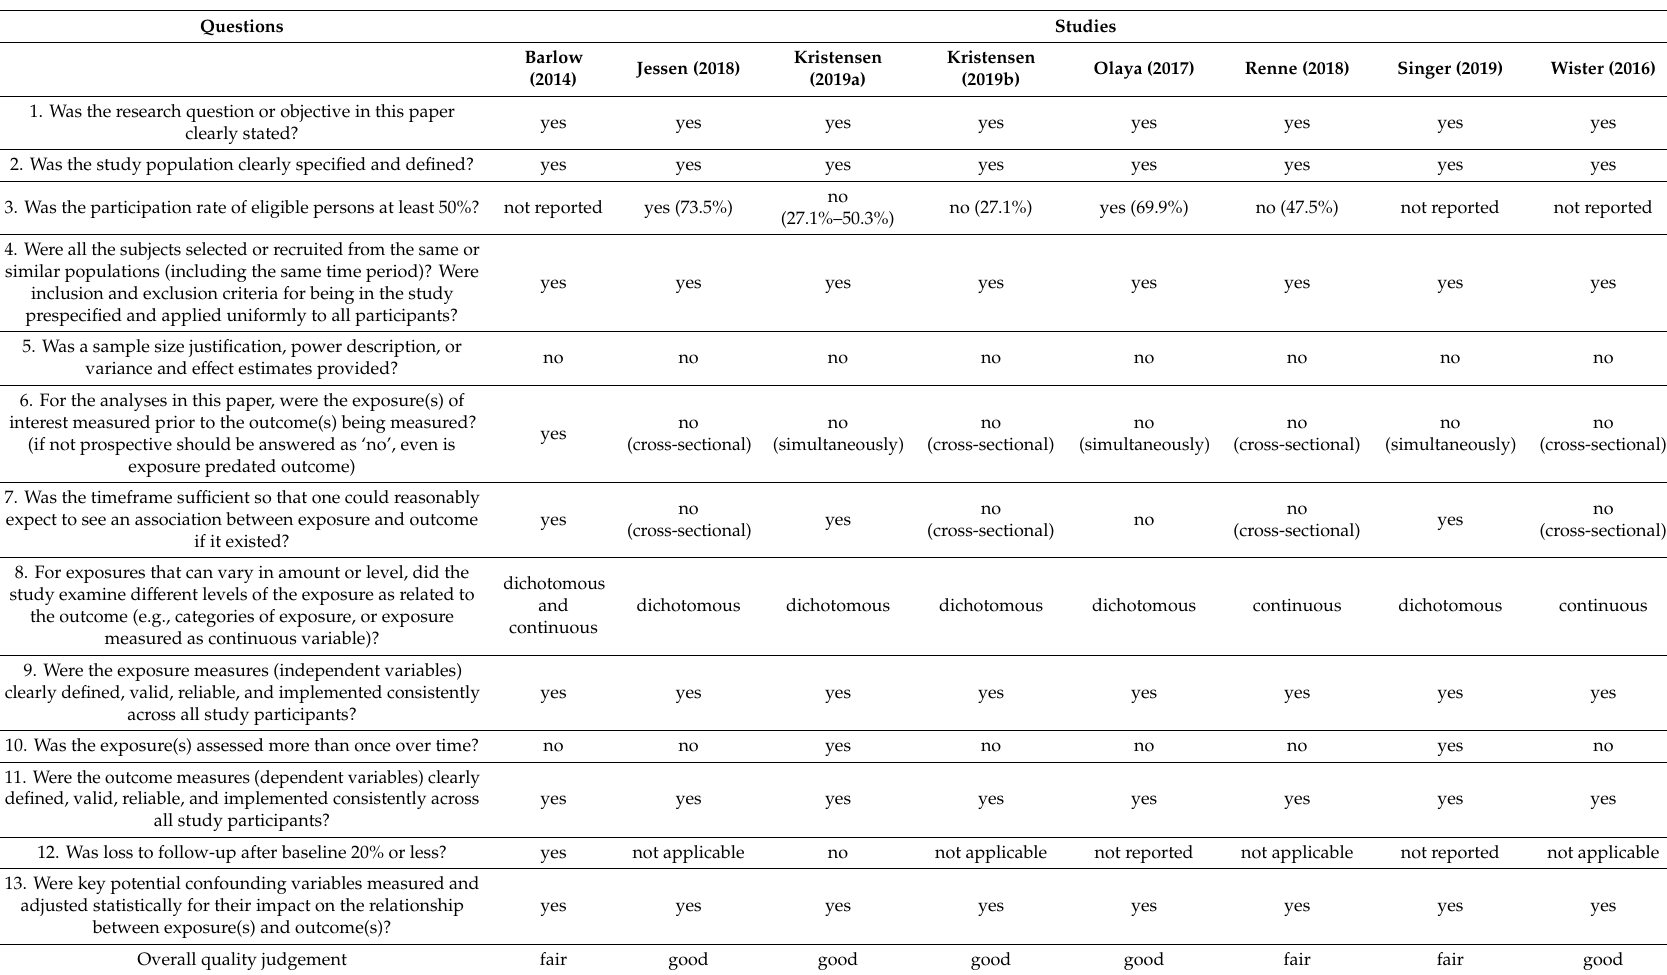
Table 3. Quality